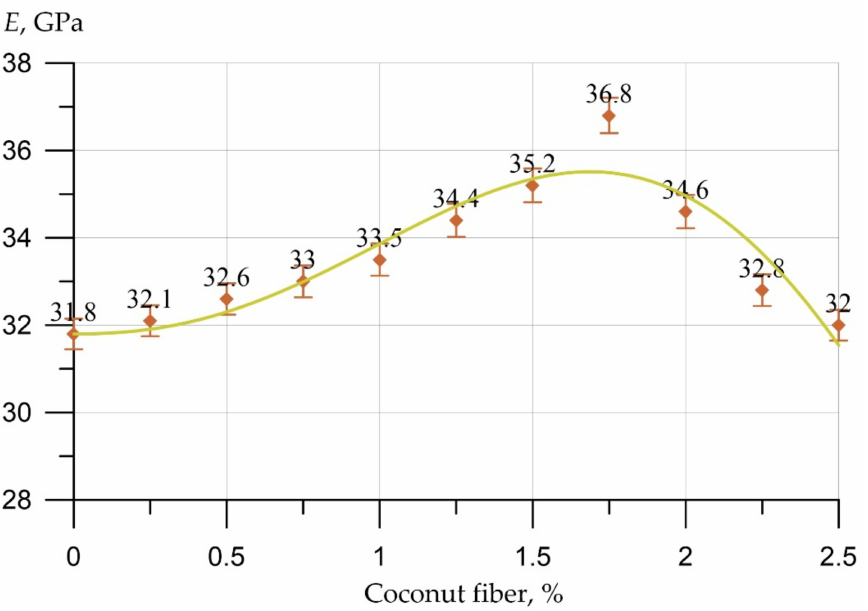
Figure 13. Dependence of the modulus of elasticity of concrete samples ( E ) on the percentage of dispersed reinforcement with coconut